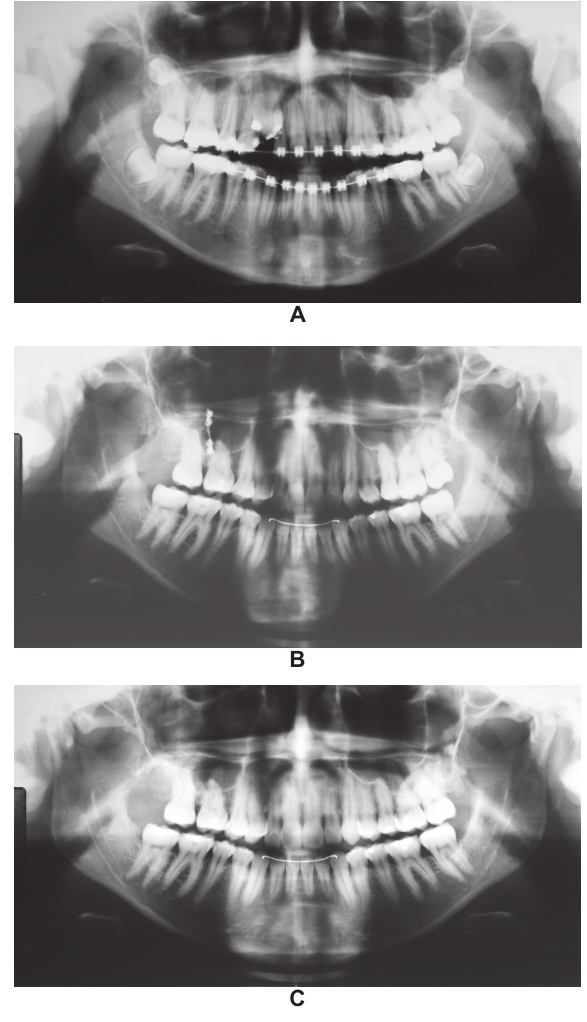
Figure 3- Panoramic radiographic sequence. A.